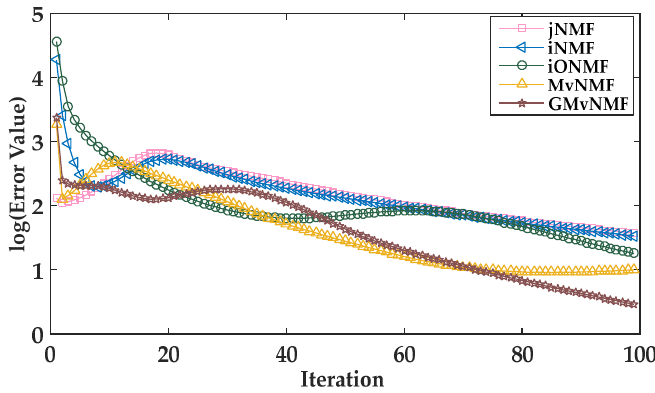
Figure 3. Convergence curves of joint Non-negative Matrix Factorization (jNMF), integrated NMF (iNMF), integrative orthogonality-regularized NMF (iONMF), MvNMF, and GMvNMF.